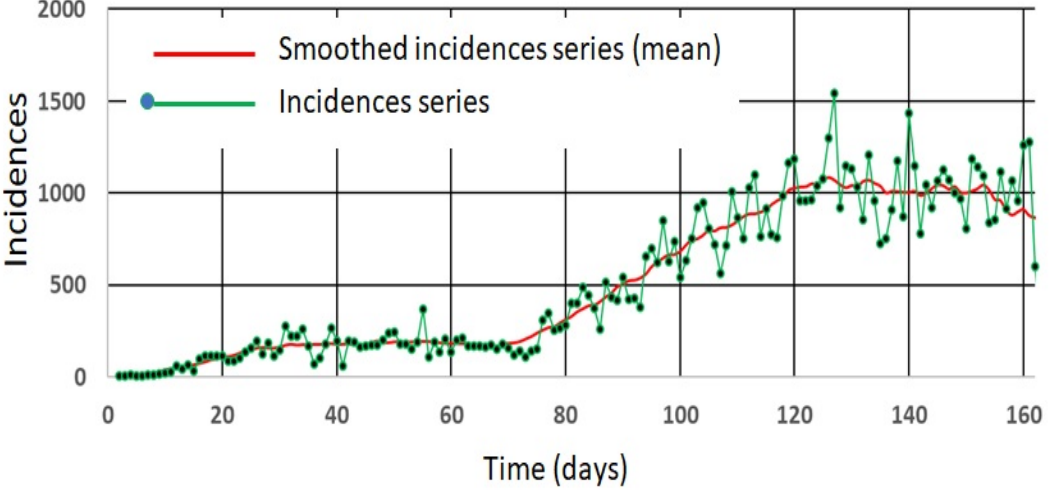
Figure 1. Partial series of incidence and smoothed incidence (mean) of the COVID-19 pandemic, Panama 2020, showing a typical pattern of variation around the mean.